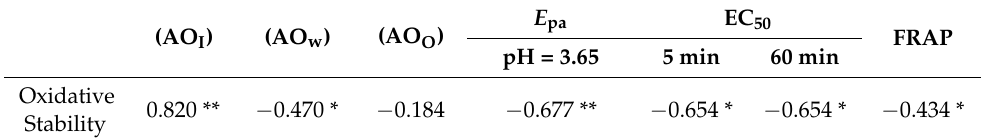
Table 2. Pearson correlation between different factors and the emulsions’ oxidative